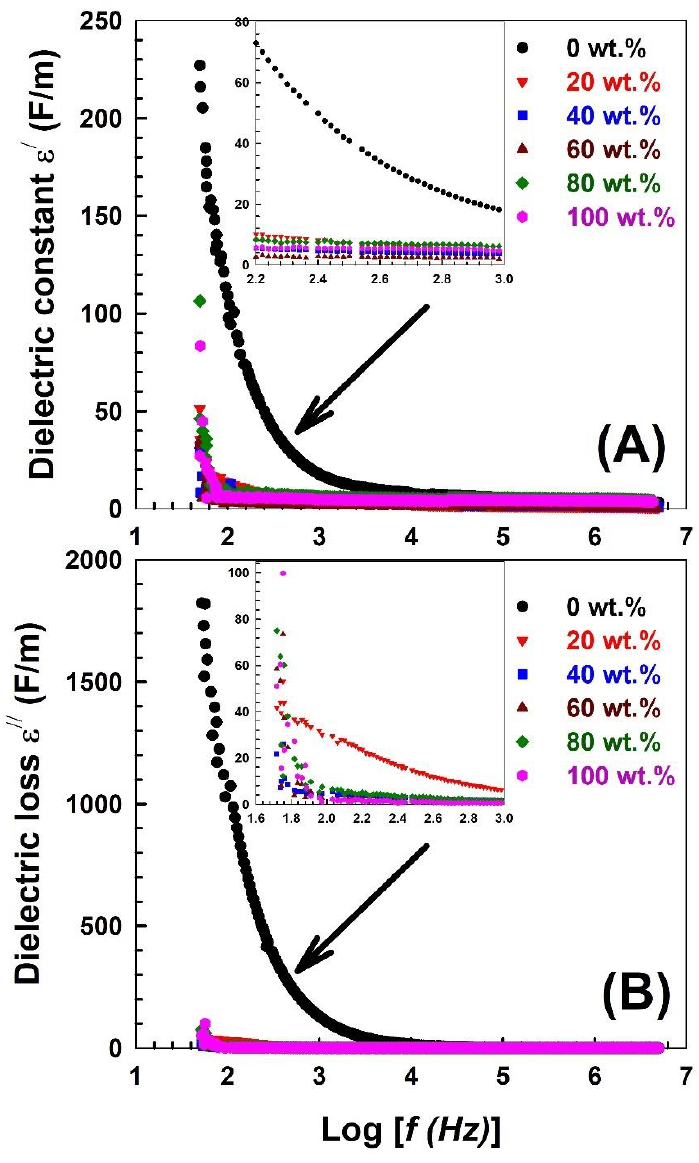
Figure 4. Frequency dependence of ( A ) the dielectric constant ε′ and ( B ) the dielectric loss ε′′ of the PVA blended with different concentrations of Nylon-6,6.